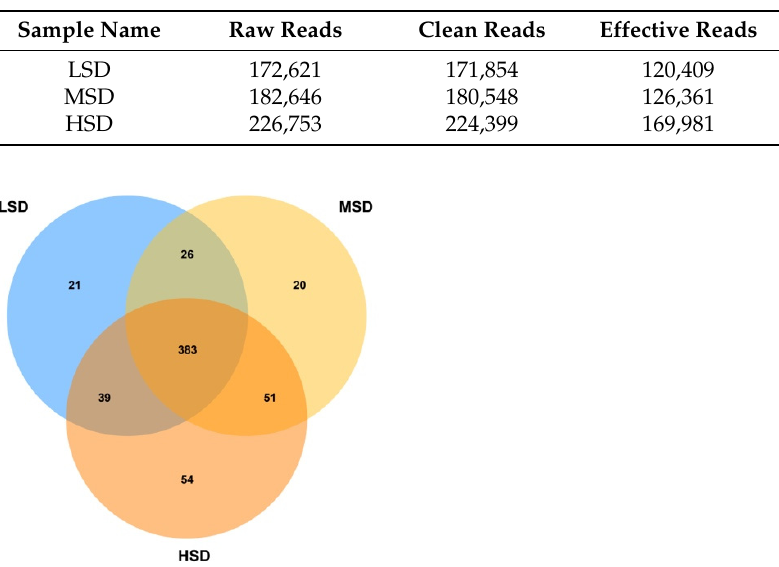
Table 2. Statistics of sequence data of all groups.